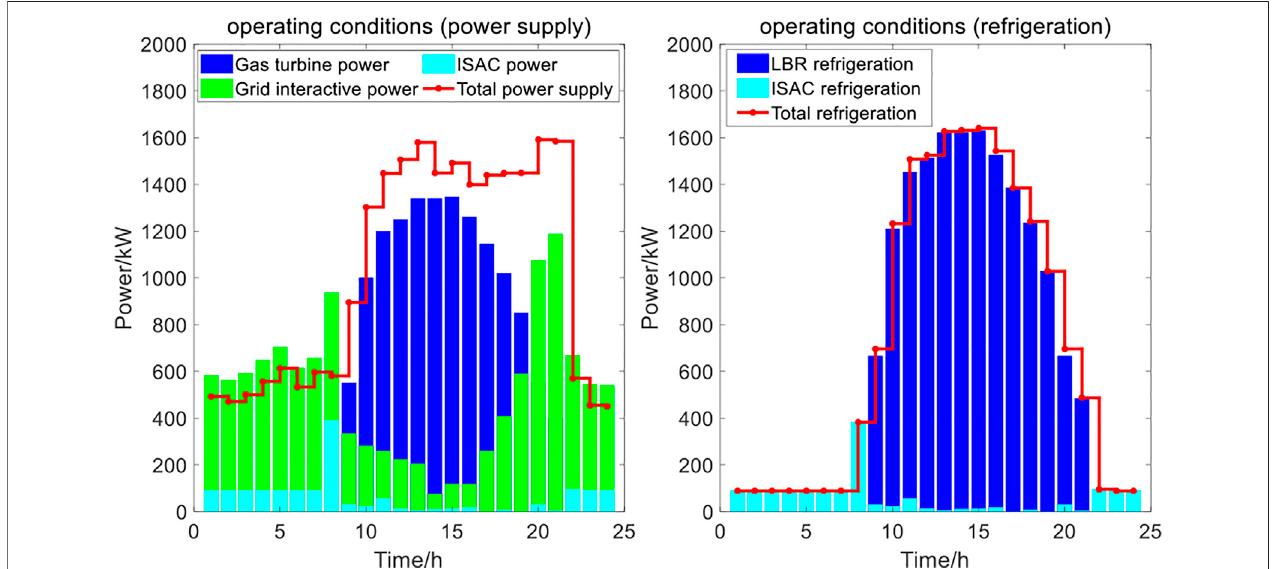
FIGURE 12 | Equipment operating conditions of ESP.